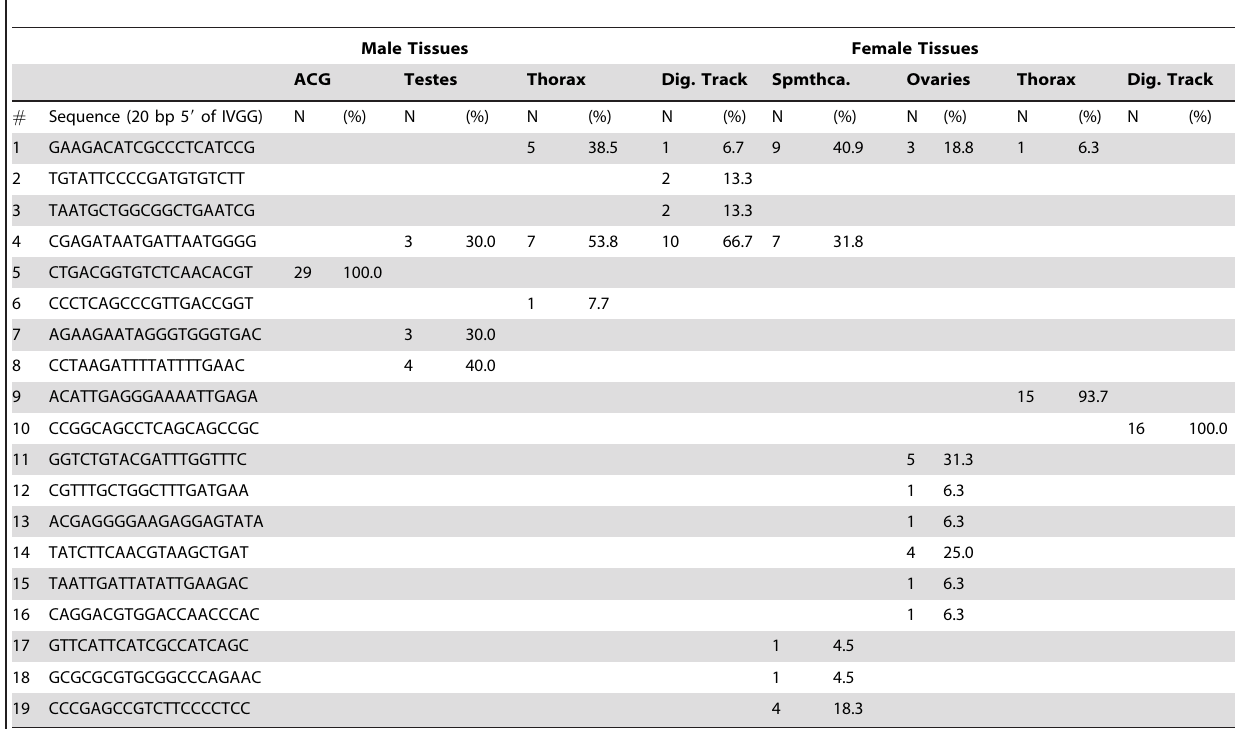
Table 3. The occurrence of specific sequences encoding putative trypsin-like serine protease in various male and female cricket